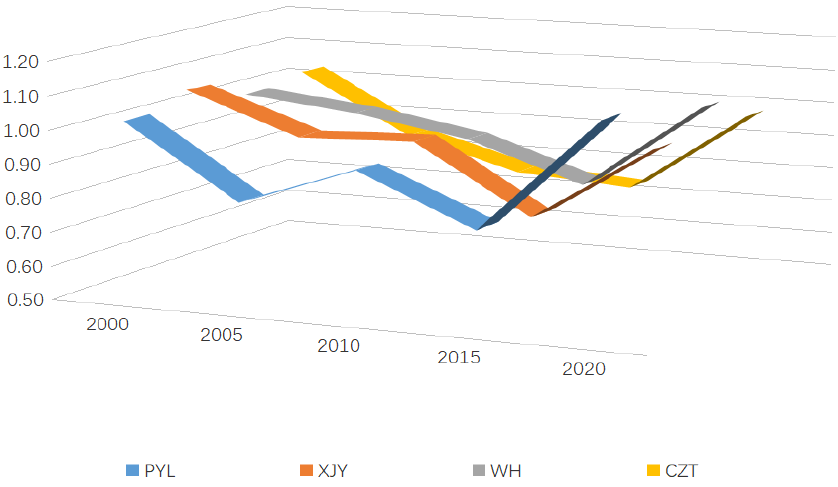
Figure 5. Average eco-efficiency of 4 urban agglomerations.